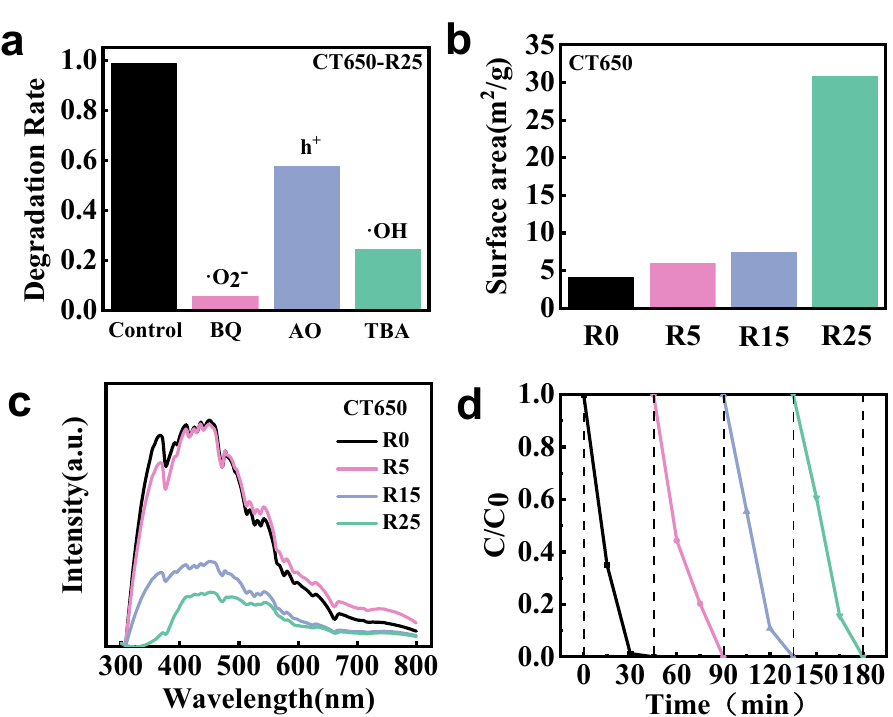
Figure 6. ( a ) The degradation rate of CT650-R25 in the presence of different scavengers. ( b ) The specific surface area and ( c ) PL spectra of CT650-R0, R5, R15 and R25. ( d ) Photocatalytic performance of recycled CT650-R25 catalyst.